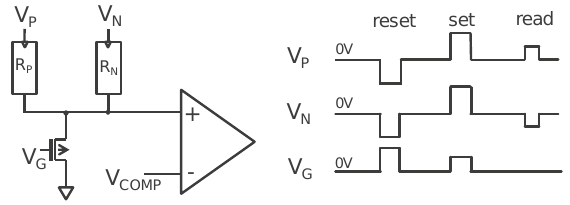
Figure 9: Schematic and timing diagram of the RRAM with parallel SET. The readout can be done by comparing the voltage at middle node to a reference